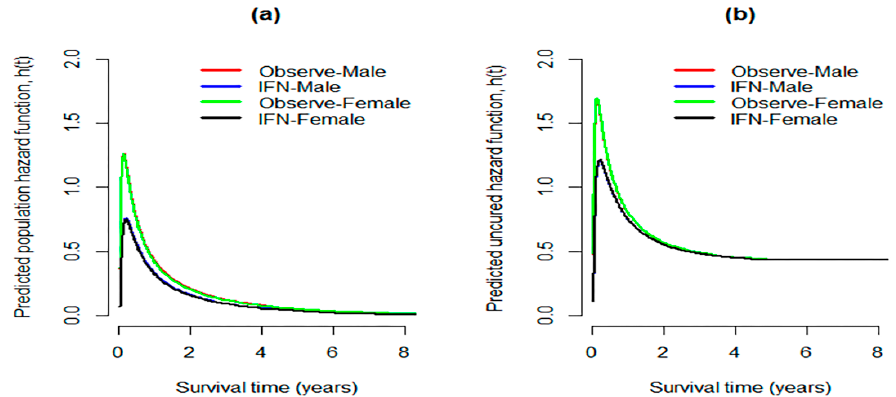
Figure 5. ( a ) Predicted population risk functions considering MCM model with EWE distribution; ( b ) respective susceptible hazard functions.